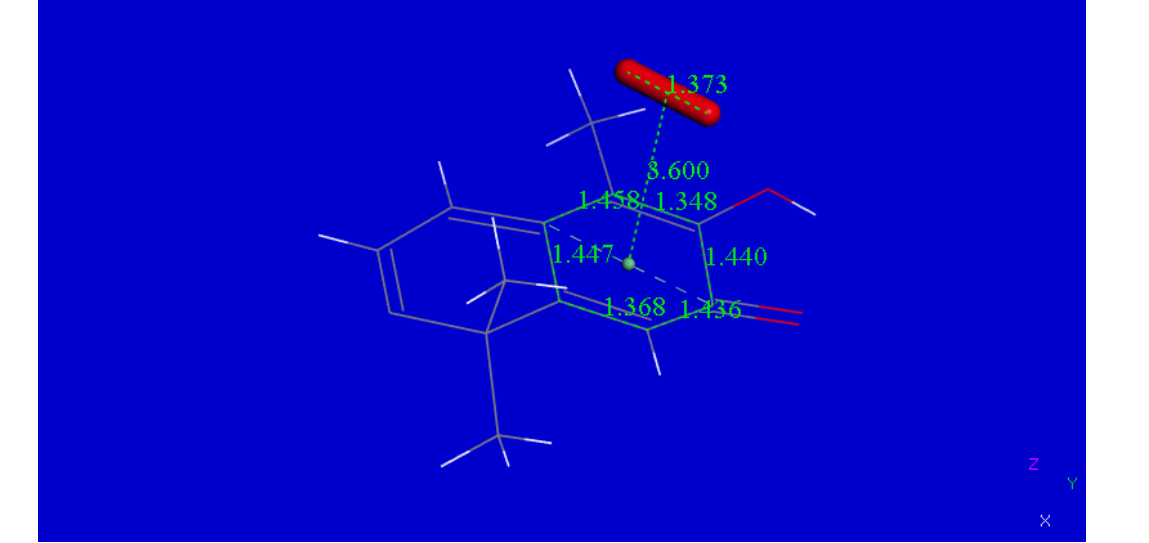
Figure 8. Superoxide π-π approached by model celastrol. Initial state.